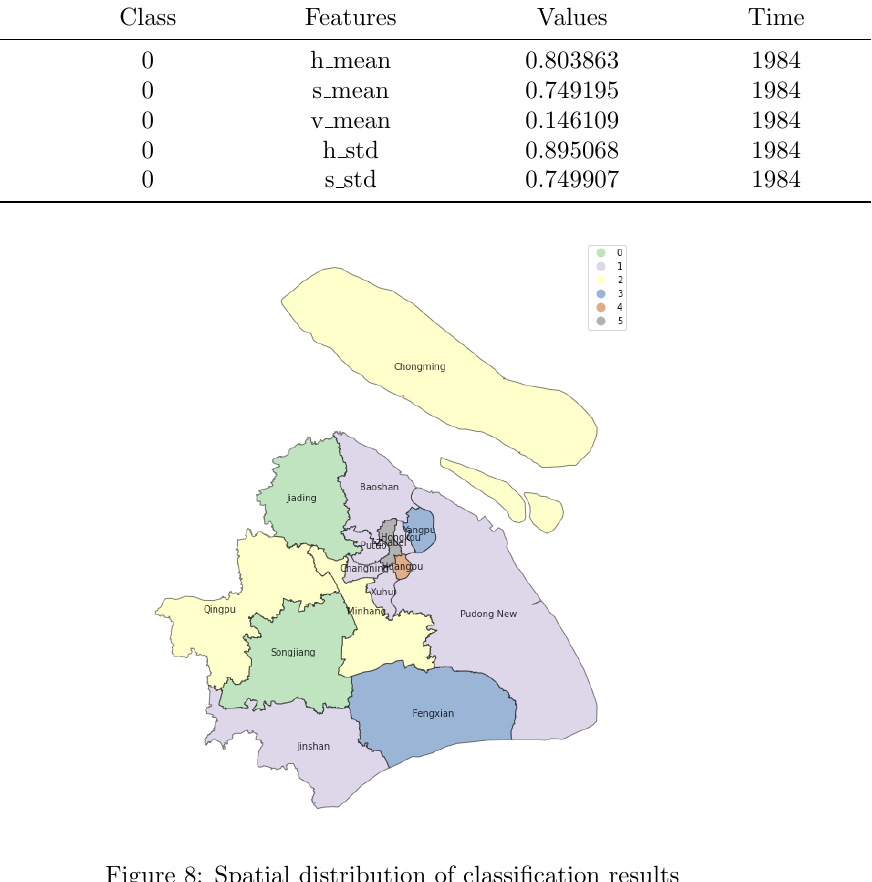
Figure 8: Spatial distribution of classification